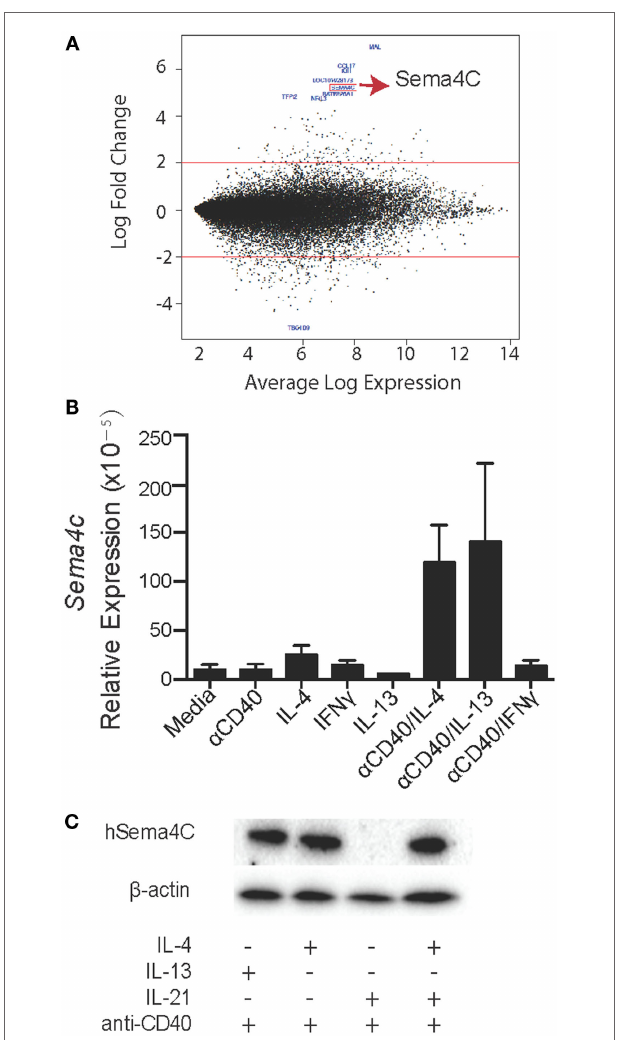
FigUre 1 | expression profile of human B-cells identifies sema4c as a Th2-induced gene . (a) As part of a larger study on human allergic B-cell responses, human tonsillar B-cells were isolated by RosetteSep Human B-Cell Enrichment Cocktail, followed by anti-CD40 + IL-4 stimulation. After 24 h, RNA was collected from stimulated cells. RNA samples were analyzed using Affymetrix GeneChip Human Genome U133 Plus 2.0 microarrays. M–A [minus log(2)-fold-change versus average log-expression] plot for the contrast of anti-CD40 + IL-4 versus unstimulated B-cells. Red lines indicate the threshold of twofold change for differential gene expression. The 10 most differentially expressed genes are labeled with their NCBI gene symbol (GEO accession number: GSE71810). (B) Real-time PCR was performed to validate the microarray results. Human Sema4C mRNA was detected in tonsillar B-cells stimulated with indicated stimulators for 24 h. mRNA samples were normalized to RPL27 as a reference gene. (c) Western blot was performed to confirm human Sema4C protein level in B-cells stimulated with indicated stimulators for 5 days. Means ± SEM, n = 10, * p <